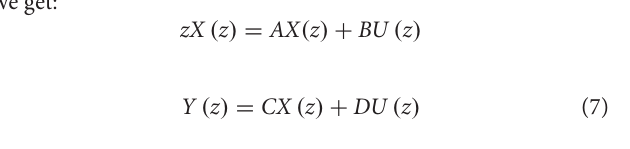
where x is the state vector, u is the input vector and y is the output vector. Assuming that all rectifier units are ideal, that is, the on-resistance of the diode is 0, there is no on-voltage drop,